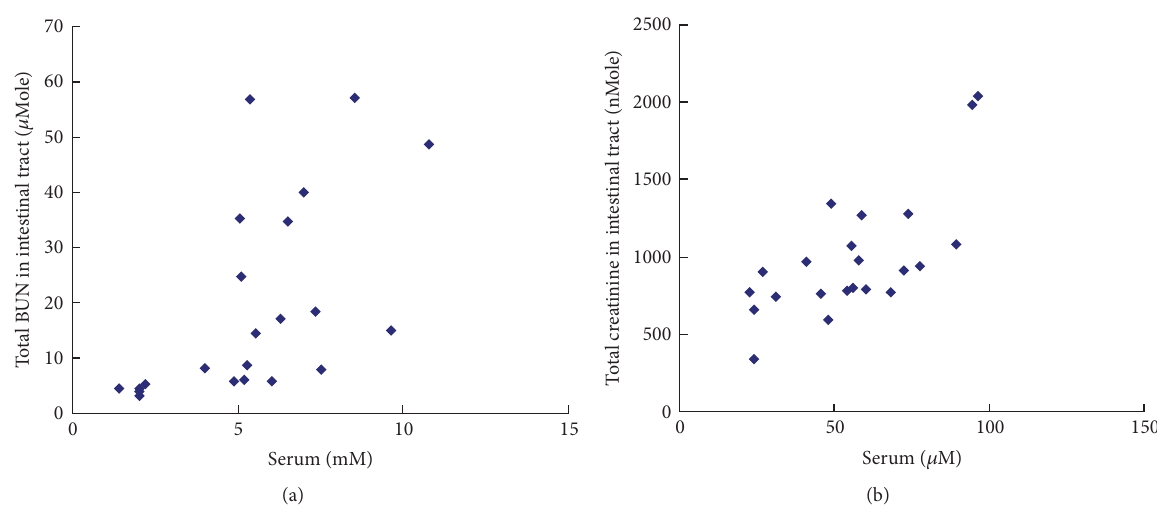
Figure 7: The correlations of BUN (a) and creatinine (b) between serum and intestinal tract ( 𝑛 = 20 ). The relationship in (a) showed that the totalBUN( 𝜇 Mole)inintestinaltractwasproportionatetothelevelofBUNinserum,andthecoefficientofcorrelation( 𝑅 )was0.582( 𝑃 < 0.05 , Pearson Correlation, 2-tailed). The relationship in (b) showed that the total creatinine (nMole) in intestinal tract was also proportionate to the level of creatinine in serum, and the coefficient of correlation ( 𝑅 ) was 0.710 ( 𝑃 < 0.05 , Pearson Correlation, 2-tailed).